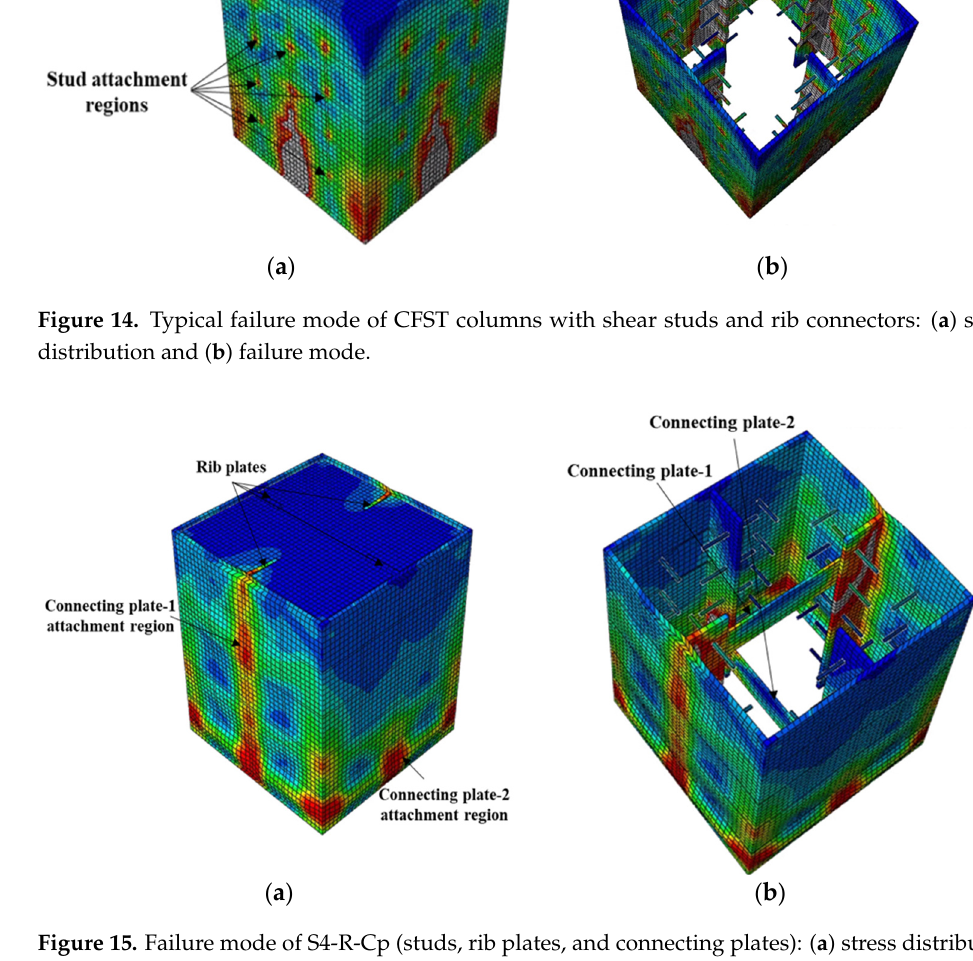
Figure 14. Typical failure mode of CFST columns with shear studs and rib connectors: ( a ) stress distribution and ( b ) failure mode.